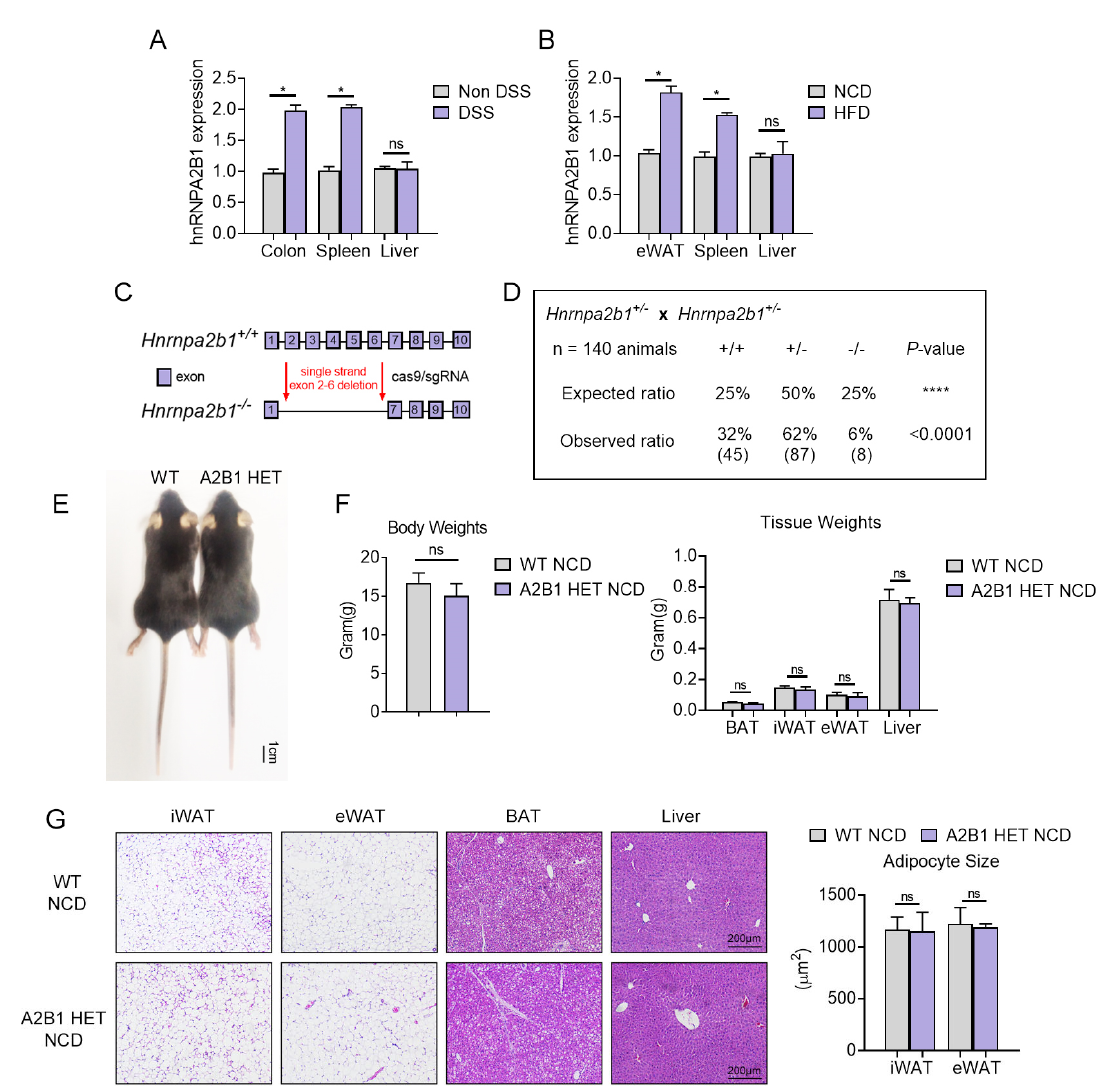
Figure 1. Phenotypic analysis of hnRNPA2B1 heterozygous mice. ( A , B ) Expressing profile of hnRNPA2B1 in different tissues of DSS-induced colitis mice and high-fat-diet (HFD)-induced obesity mice. ( C ) Schematic diagram for establishment of hnRNPA2B1 gene by CRISPR/Cas9 gene editing technology. ( D ) Birth rate of the different hnRNPA2B1 genotypes mice in NCD (normal chow diet). ( E ) Appearance of A2B1 HET NCD mice compared with that of WT NCD mice. ( F ) Body weights and weights of metabolic tissues including brown fat, inguinal fat, epididymal fat and liver. ( G ) Hematoxylin and eosin (H&E) staining of liver and adipose tissues. Results are shown as mean ± SEM; ns, not significant; * p < 0.05, **** p < 0.0001.